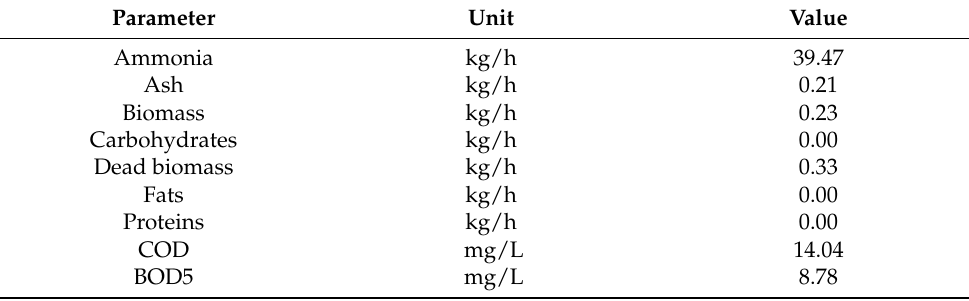
Table 10. Simulated treated water characteristics.